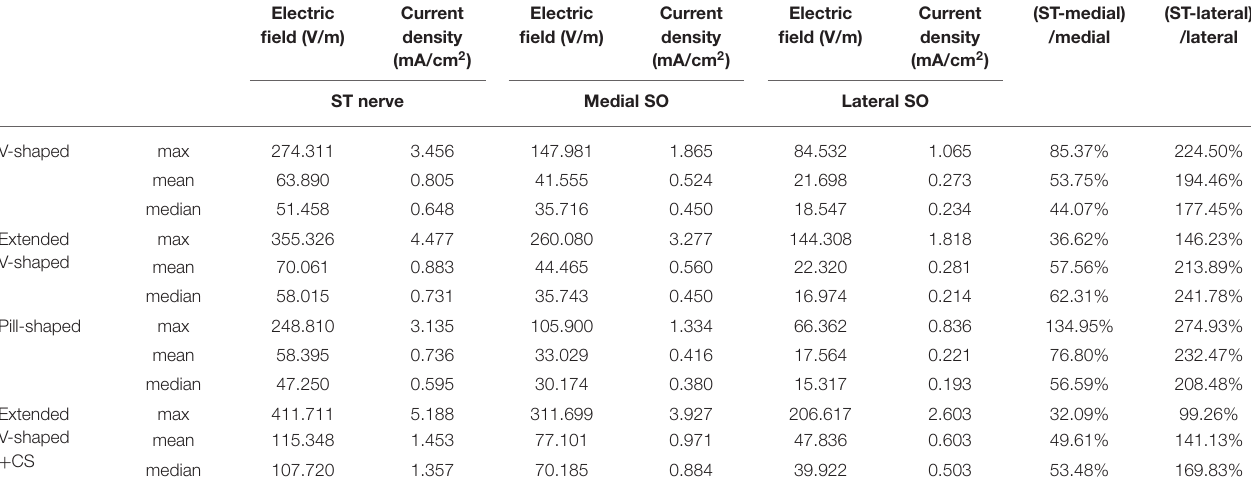
FIGURE 4 | Detailed analysis of induced flow on the left trigeminal nerves. We partitioned each of the individual target nerves (ST, Medial SO, Lateral SO) into three subsections (1, 2, and 3) to facilitate easier comparison across the four montages. The extended V-shaped + CS configuration results in more comparable current flow in each of the three target nerves. For the first three montages, we did not notice any marked difference in the overall flow. Given symmetric patch placement, we expect the same observation in the right trigeminal nerves. TABLE 4 | Induced EF, current density, and percentage increase of EF induced at ST nerve with respect to the other